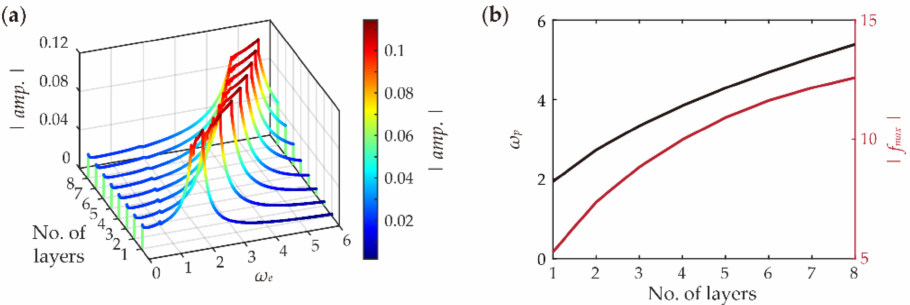
Figure 9. Effects of the number of DEA layers on ( a ) the frequency responses and ( b ) the peak frequency and peak impact force of the resonant-impact DEA